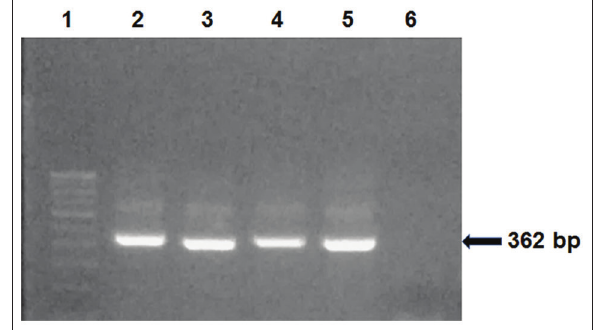
Figure-2: Amplification of enterovirus nucleic acid using nested primers ENV-F and ENV-R2. Lane 1: 100 bp DNA ladder, Lane 2: Positive control, Lanes 3 and 4: Saccostrea cucullata , Lane 5: Meretrix meretrix , Lane 6: Negative